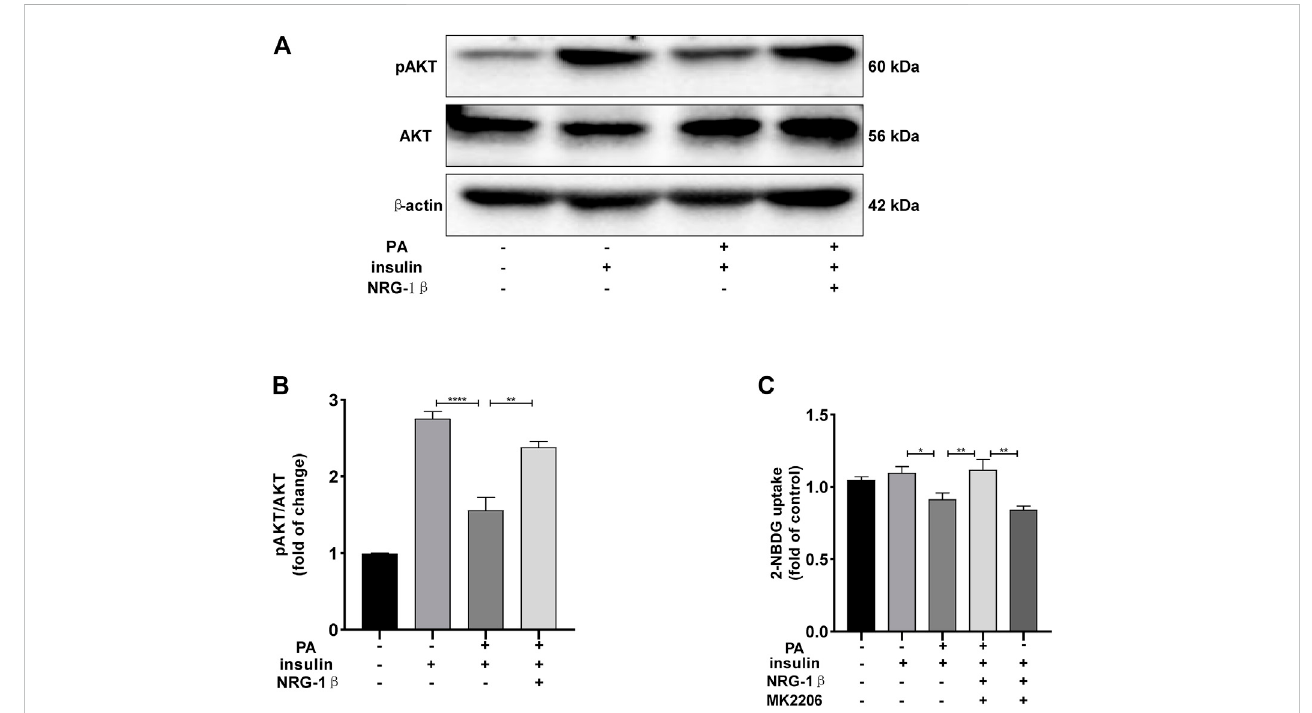
FIGURE 3 NRG-1 β increased glucose uptake in PA-treated C2C12 myotubes by activating the PI3K/AKT signaling pathway. Effects of NRG-1 β on levels of AKT and Phosphor-Akt(ser473)inPA-treated (plusinsulin)C2C12 myotubesweredetected via Westernblotting (A,B) .Dimethylsulphoxide(DMSO)or10 μ MMK2206 (an AKT inhibitor) in DMSO was added before culturing .25 mM PA-treated (plus insulin) C2C12 myotubes, effects of MK2206 on glucose uptake using the 2- NBDG assay (C) . The data are presented as the mean ± SEM. * p < .05; ** p < .01; **** p < .0001.